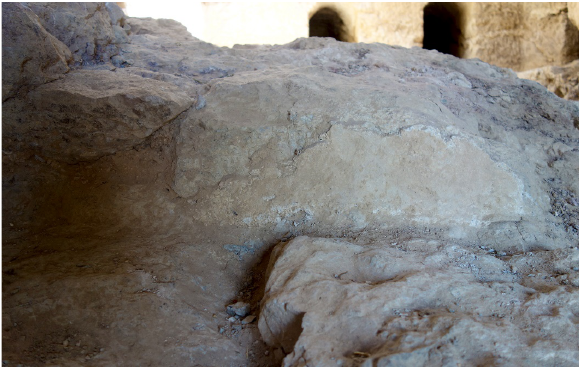
Figure 6. White mortar at the bottom of the